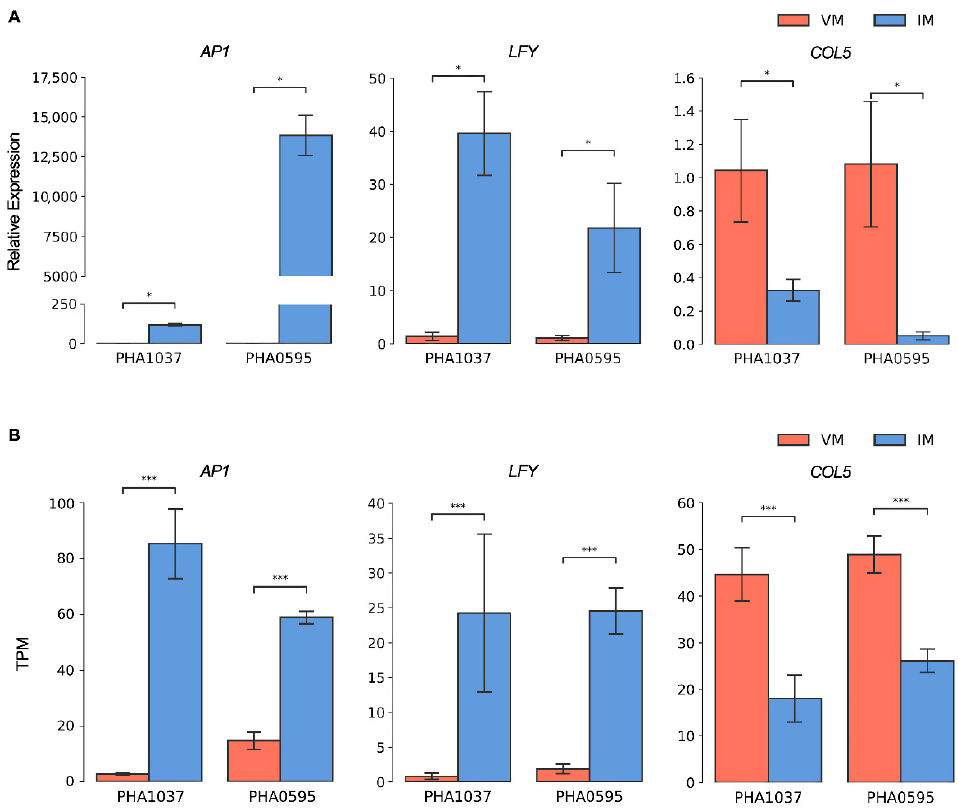
Figure 7. Validation of gene expression profiles obtained from RNA-seq by qRT-PCR. Expression patterns of the homologues of the Arabidopsis APETALA1 ( AP1 ; Phvul.003G281000 ), LEAFY ( LFY ; Phvul.009G160900 ) and CONSTANS-LIKE 5 ( COL5 ; Phvul.003G149000 ) genes examined by RT-qPCR ( A ) and RNA-seq ( B ) assays in vegetative axillary meristems (VM) and inflorescence meristems (IM) stages for the photoperiod-sensitive nuña PHA1037 accession and the early-flowering bean PHA0595 cultivar. Error bars represent the standard deviation from three biological replicates. Significant differences detected using Student’s t test are represented by asterisks: * p < 0.01; *** p < 0.0001.